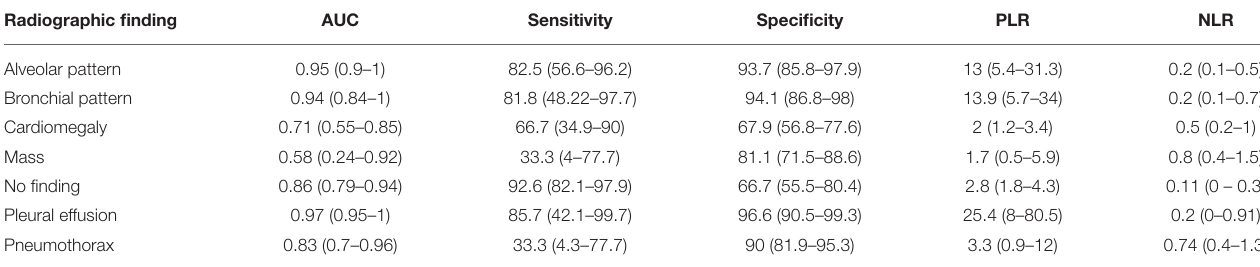
TABLE 3 | Performance of ResNet50 in the test